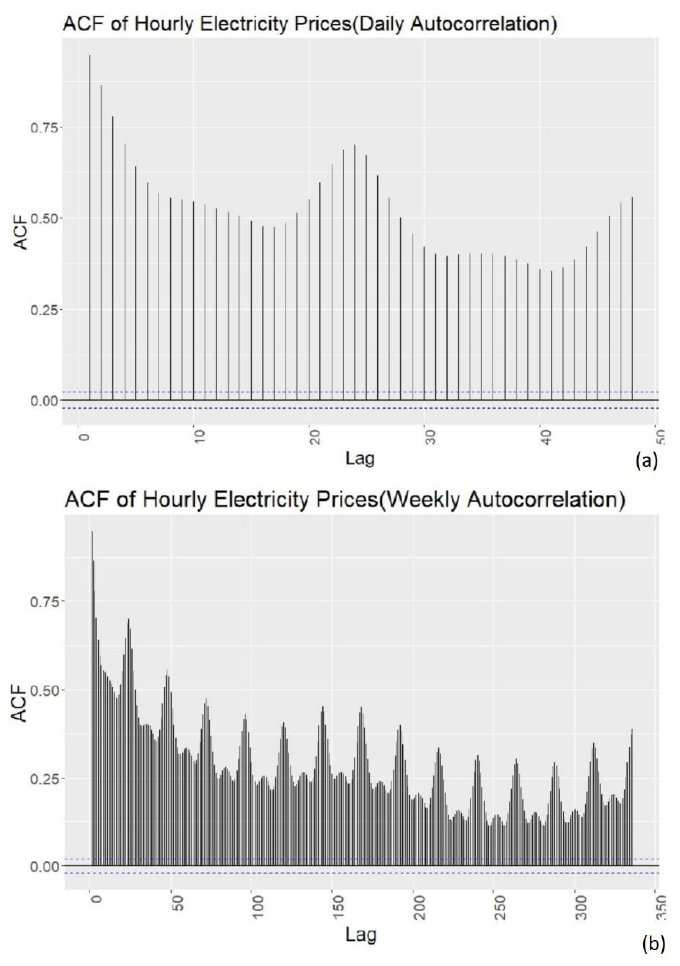
Figure 5. Hourly electricity prices: ( a ) daily and ( b ) weekly autocorrelation.